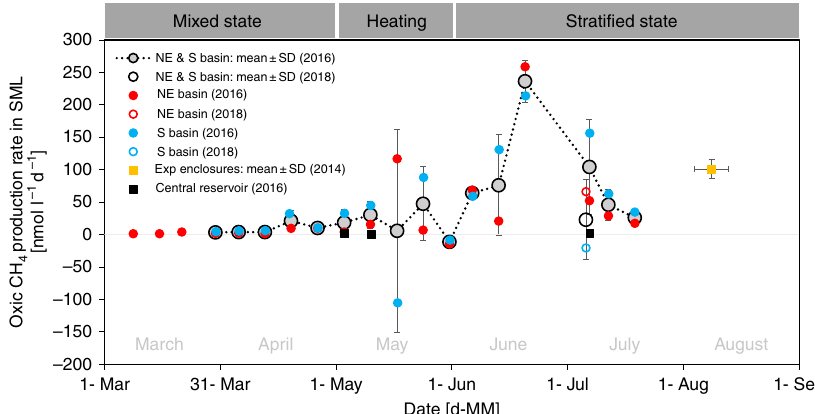
Fig. 3 Oxic methane production rates. Production rates were computed using a mass balance approach. Red circles represent measurements in the open water of the Northeast basin (69.5 m deep; 53°09'20.2''N 13°01'51.5''E) and blue circles measurements in the open water of the South basin (20.5 m deep; 53°08'36.6''N 13°01'42.8''E). Gray circles are average values of both basins. The yellow square is the average value for the experimental enclosures of the lake lab facility (enclosures 1 and 13), and black squares are measurements in the central reservoir. Vertical error bars illustrate standard deviation from mean values; and horizontal error bars (only experimental enclosures) depict the time frame of corresponding sampling. The mass balance was estimated for unstrati fi ed condition in March/April 2016 (negligible lateral methane fl ux, negligible methane oxidation) and for strati fi ed condition June – August 2014/2016/2018 (lateral methane input from sediments: 1.4 mmol m − 2 d − 1 ; 30% of internally produced methane is oxidation). For May 2016, non- strati fi ed parametrization was used for the fi rst half of the month and strati fi ed parametrization for the second half. Methane surface emission was measured in the Northeast basin (except on 20 th June 2016) and on 6 th July 2018 in the South basin, and was estimated for the other sites based on wind speed parametrization. The sampling schedule for all fi eld measurements is laid out in Supplementary Table 3. Source data are provided as a Source Data fi le.